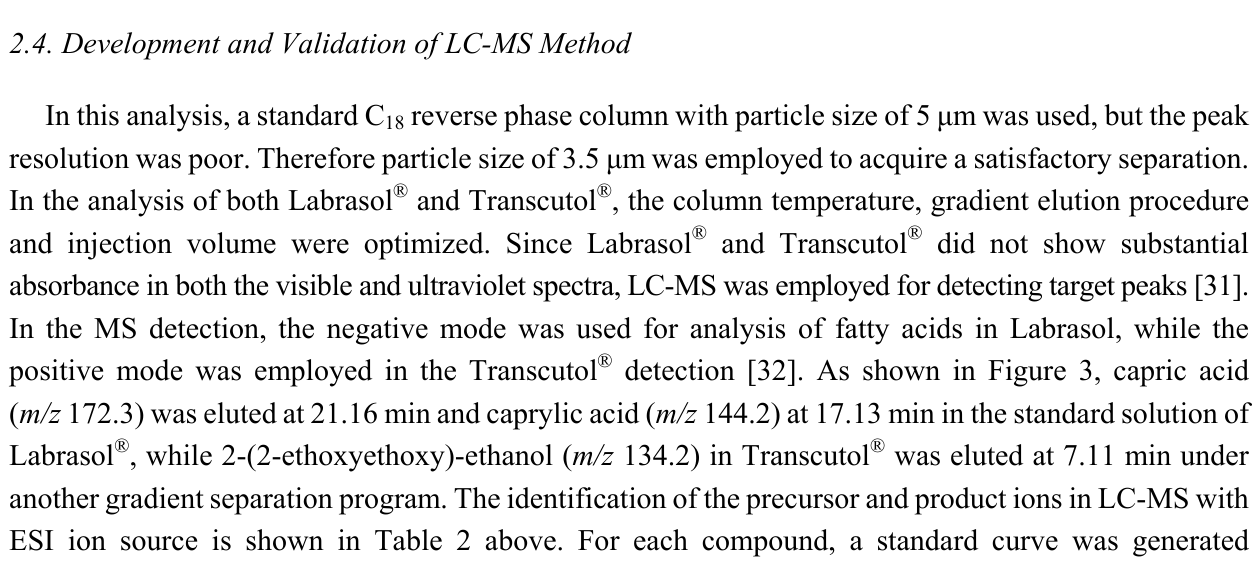
denotes retention time, R